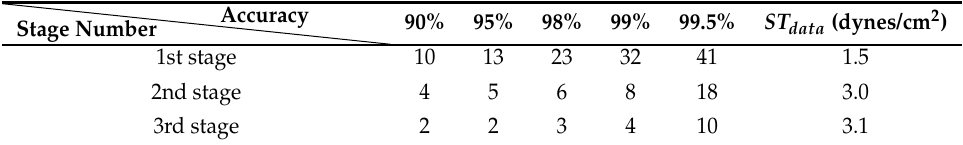
Table 2. The minimum number of modes required to reach a specified reconstruction accuracy in wall shear stress (WSS) data is shown for the coronary artery stenosis model. The spatiotemporal average of data ( ST data ) is shown for each